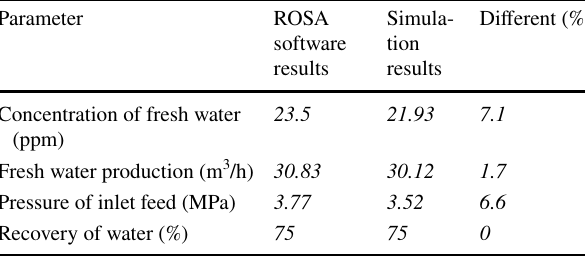
Table 8 Validation results with ROSA software